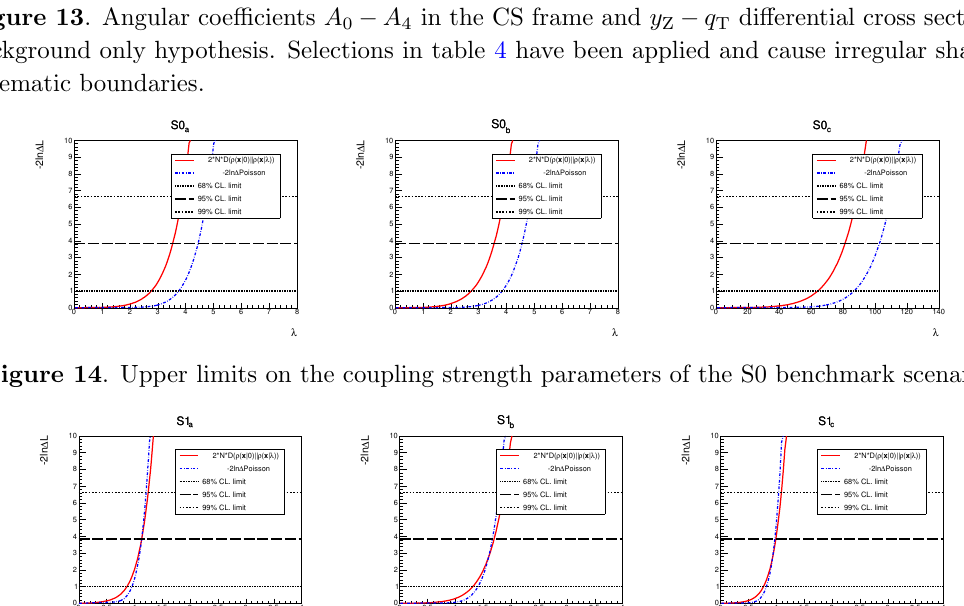
A 4 in the CS frame and y Z q T di(cid:11)erential cross section for (cid:0) (cid:0)